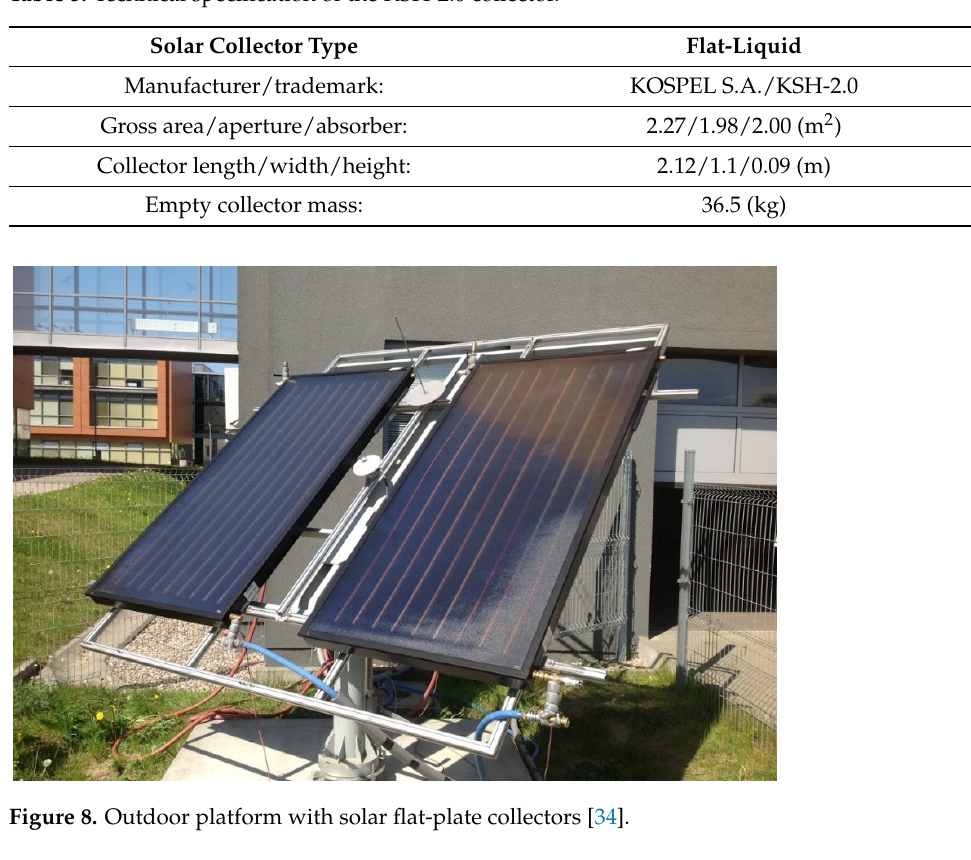
<28 Table 2. Technical specifications of the anemometer. Transducer Measuring Range (m/s) 0.02 Table 4. Technical specification of the meteorological station.